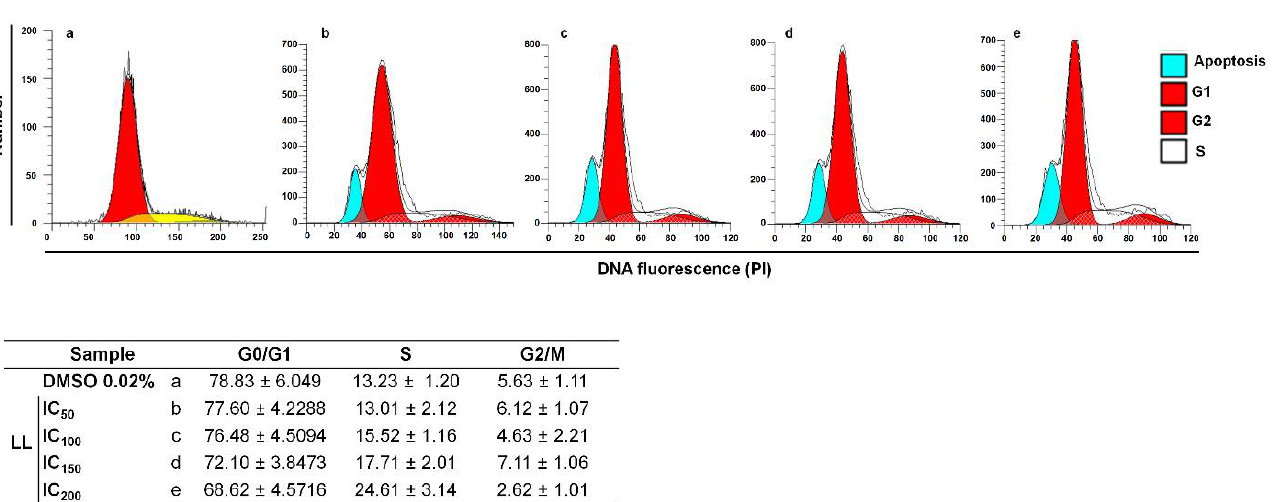
Figure 2. Linearolactone (LL) causes a partial arrest at the S phase in Giardia intestinalis trophozoites. ( A ) Trophozoites of strain WB were exposed to vehicle [0.02% dimethyl sulfoxide (DMSO)] ( a ) and LL at IC 50 ( b ), IC 100 ( c ), IC 150 ( d ), IC 200 ( e ), as shown in the corresponding histograms. The trophozoites were treated with RNase A, the nuclei were colored using PI and processed using flow cytometry (FCM). Peaks of the different cell cycle phases are shown at the top right of the graphs. ( B ) Percentages of cells in each cell cycle stage in the samples described above. The results correspond to the mean ± standard deviation of three independent experiments.